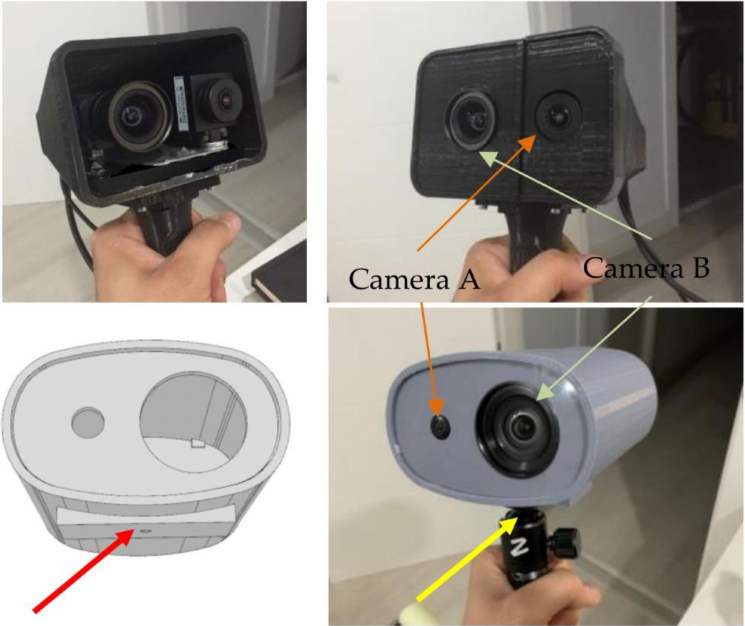
Figure 2. Initial prototype configuration P-1 (top) and the actual prototype P-2 (bottom), 14 cm long and lighter, with an extendable pole anchor point (red arrow) and a ball joint system (yellow arrow) to facilitate data